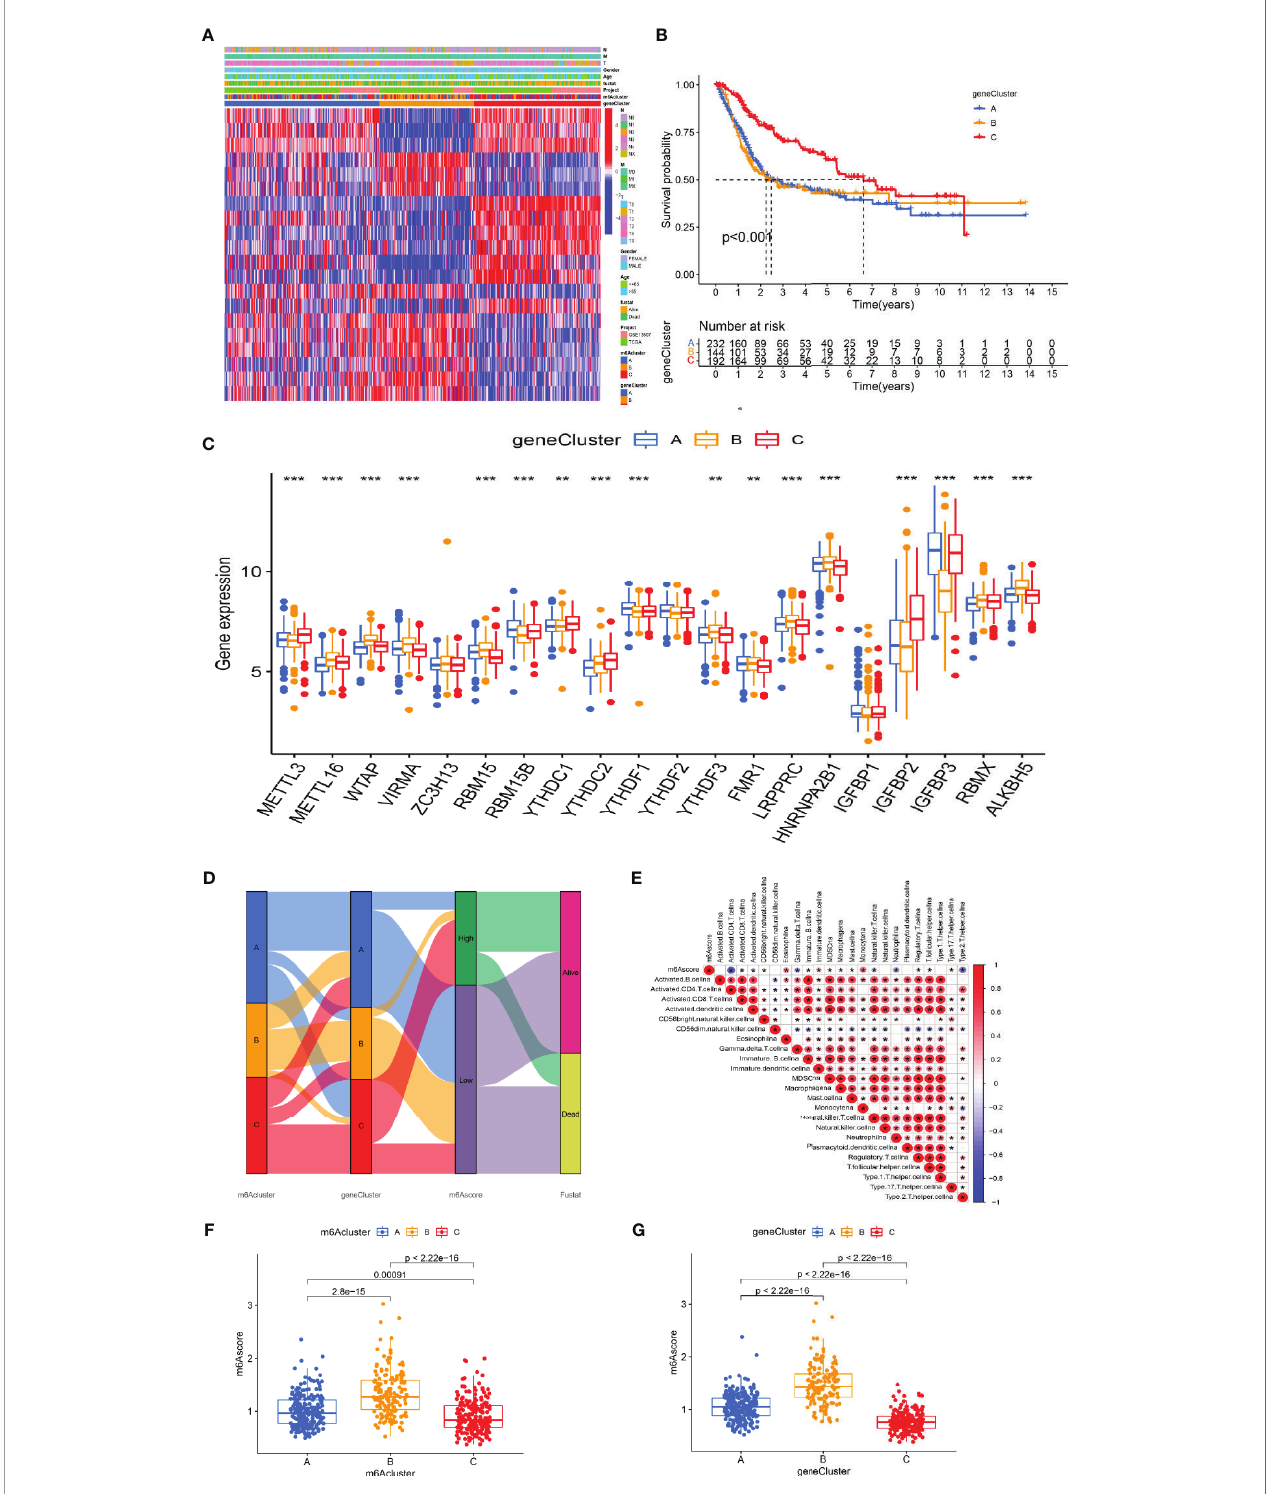
FIGURE 4 | The development of m6A signature. (A) The heat map of genetic modi fi cation patterns. (B) Survival curves of different gene-Clusters. (C) Box plot of the differential expression analysis of m6A-related genes among different gene-Clusters. The *** represents p < 0.0001, ** represents p < 0.01. (D) Sankey diagrams of different genotypes. (E) The correlation analysis between the m6A score and immune cells, with red indicating positive correlation and blue indicating negative correlation. (F) Differential expression analysis of the m6A score in the m6A cluster. (G) Difference analysis of the m6A score in the